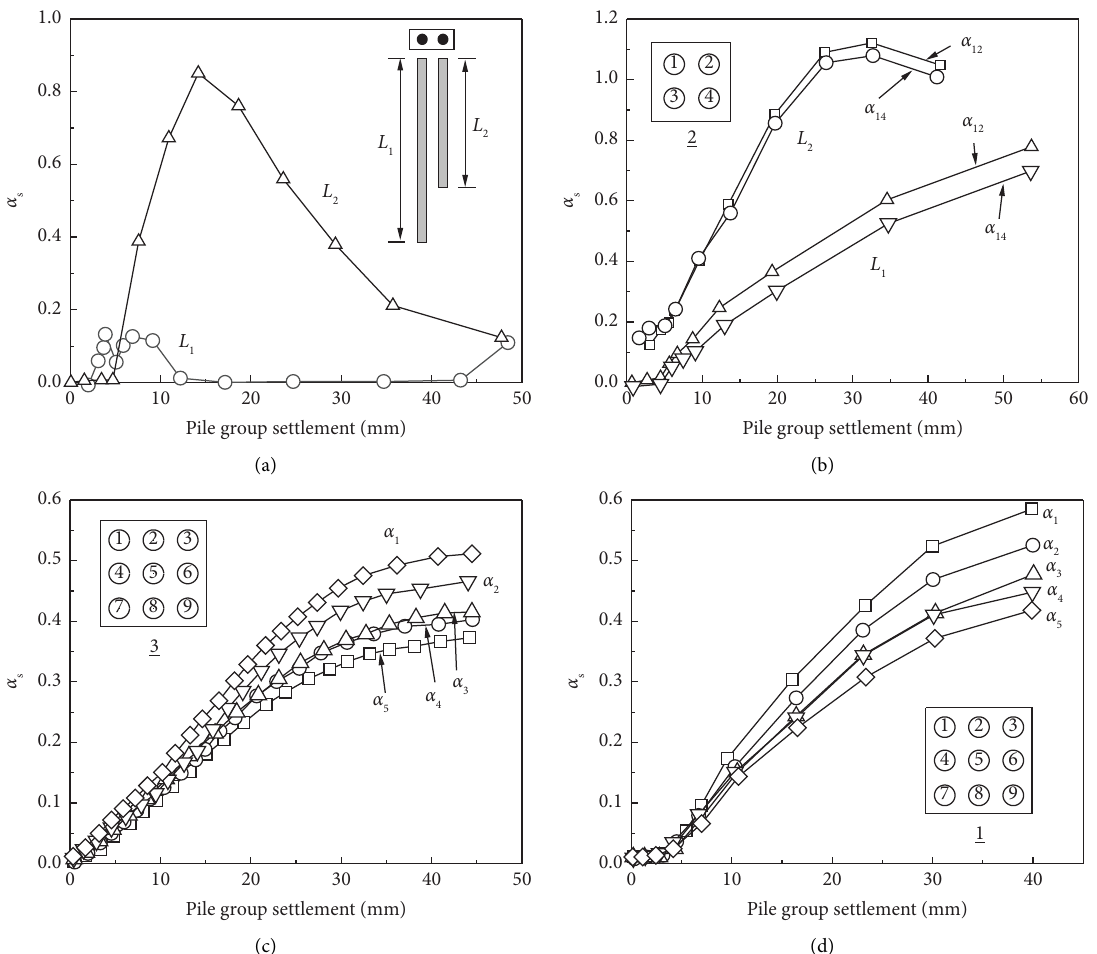
Figure 10: Interaction factor versus settlement for each group pile. (a) Two-group pile with L L 1 � 24m and L 2 � 20 m, (c) nine-group pile with L 2 � 20m, and (d) nine-group pile with L 1 �